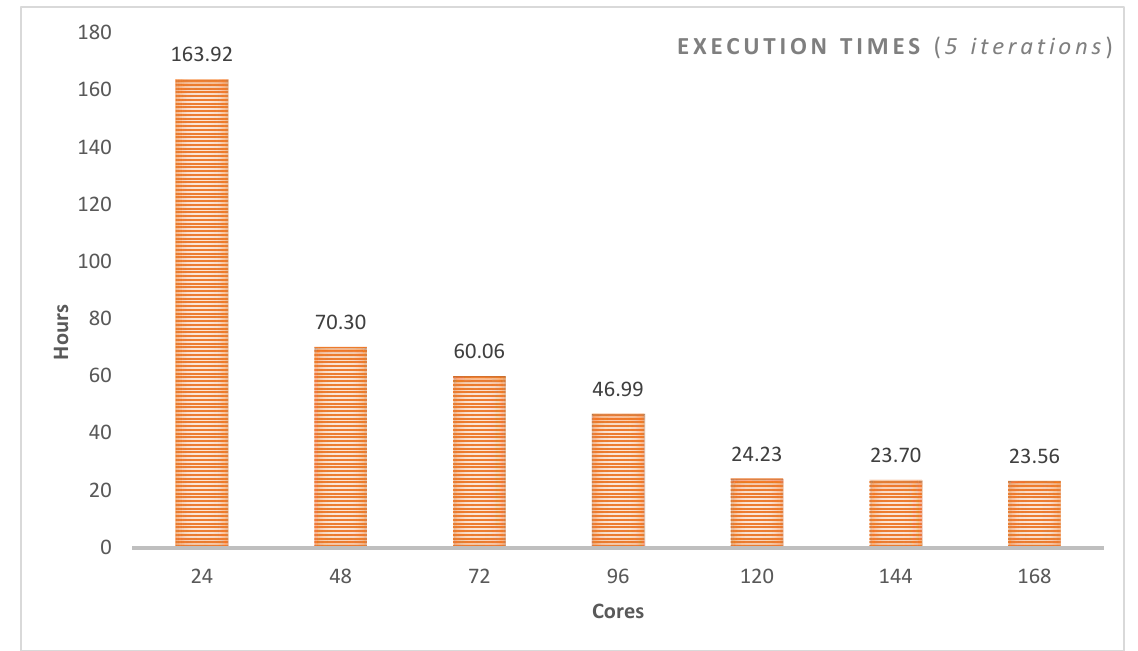
Figure 16. Execution time vs. number of cores for varying number of LDA iterations (no limit on the number of features).